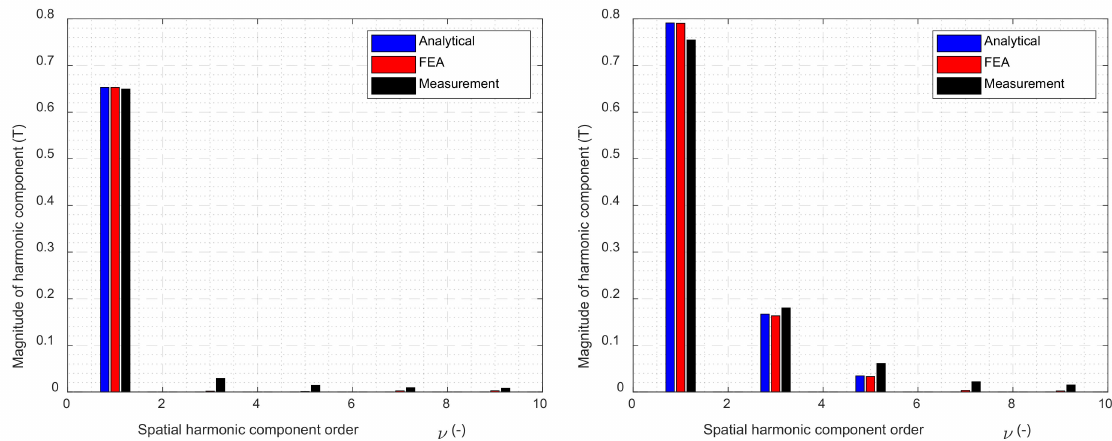
Figure 12. Spectrum of air gap magnetic flux density excited by single and higher order harmonic components injection obtained by analytical calculation, FEA, and